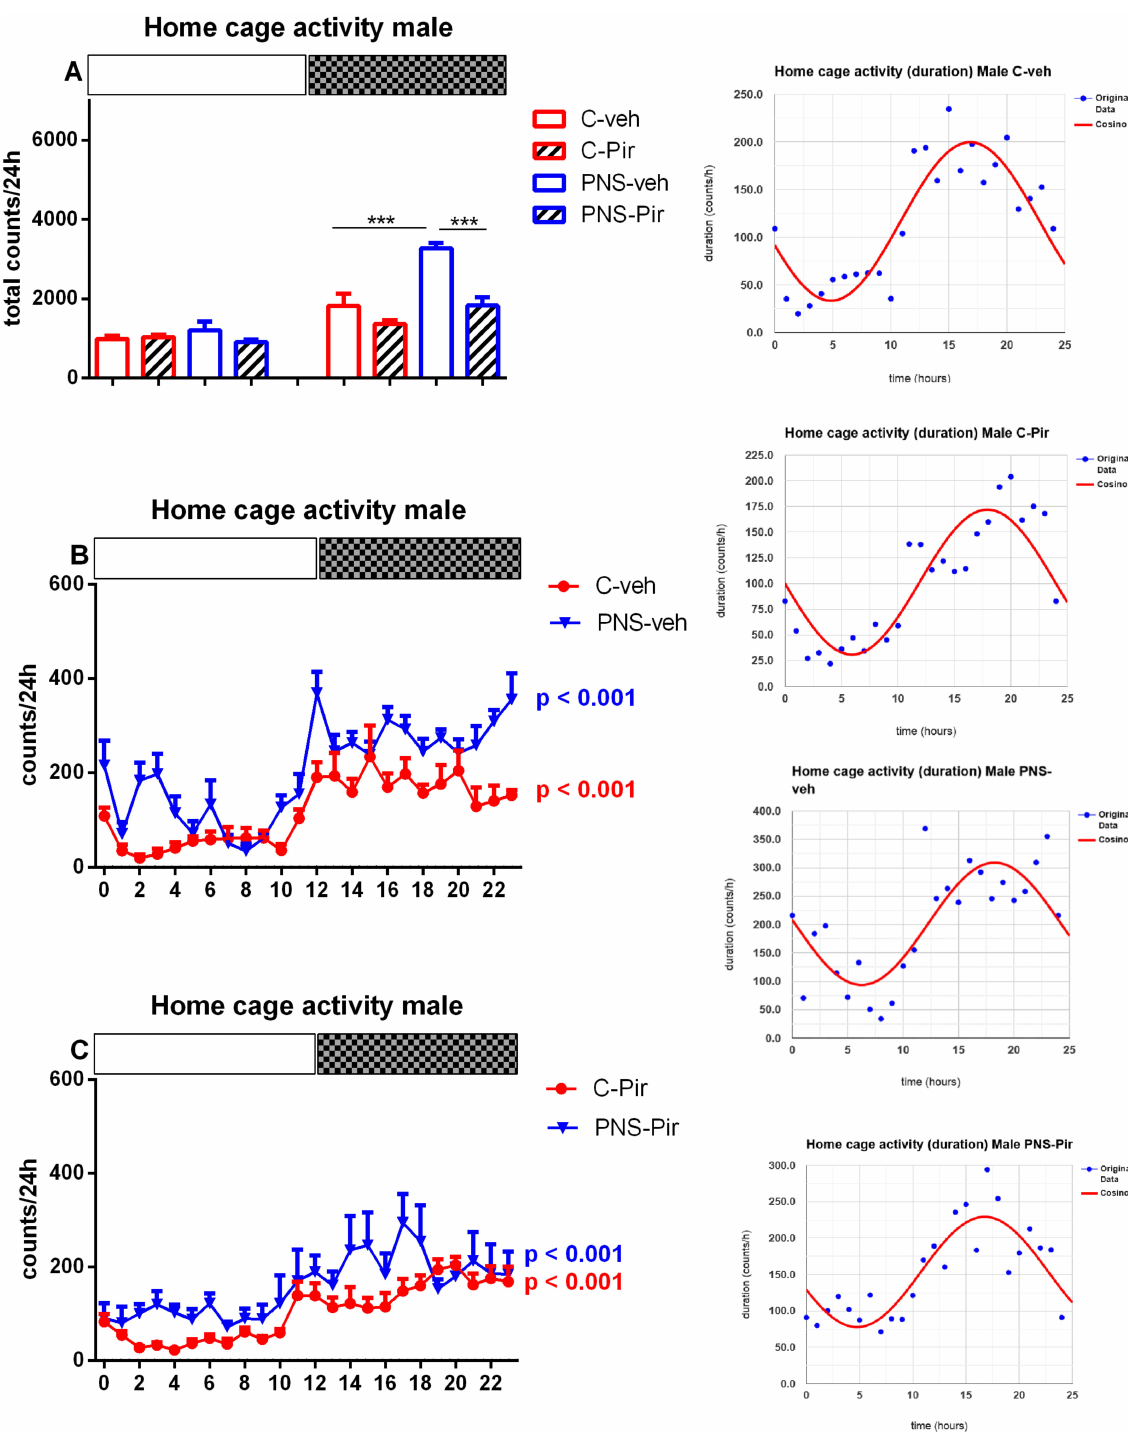
Figure 1. Diurnal variations of home cage activity (total counts) in male rats during the Light and the Dark phase (24-h period registration) for C-veh, C-Pir, PNS-veh and PNS-Pir group ( A ). Light and dark periods are indicated by open and black rectangles above the figure. Data are presented as mean ± SEM, n = 8/group. Circadian distribution of motor activity (counts/h) for C-veh and PNS-veh groups ( B ) and C-Pir and PNS-Pir groups ( C ) over a 24-h recording. Original and cosinor data are shown in the inset on the right. *** p < 0.001 vs. C-veh (Dark phase); *** p < 0.001 vs. PNS-veh group (Dark phase),